Question: Identify the chart type used in this figure.
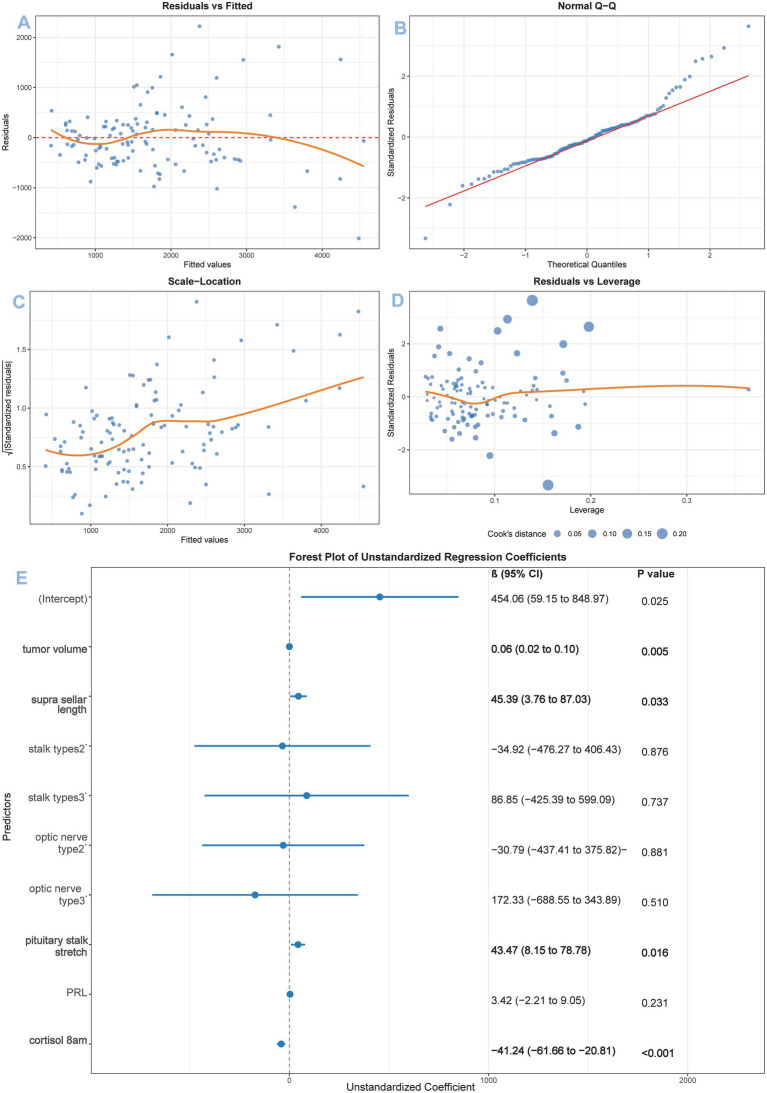
Answer: forest